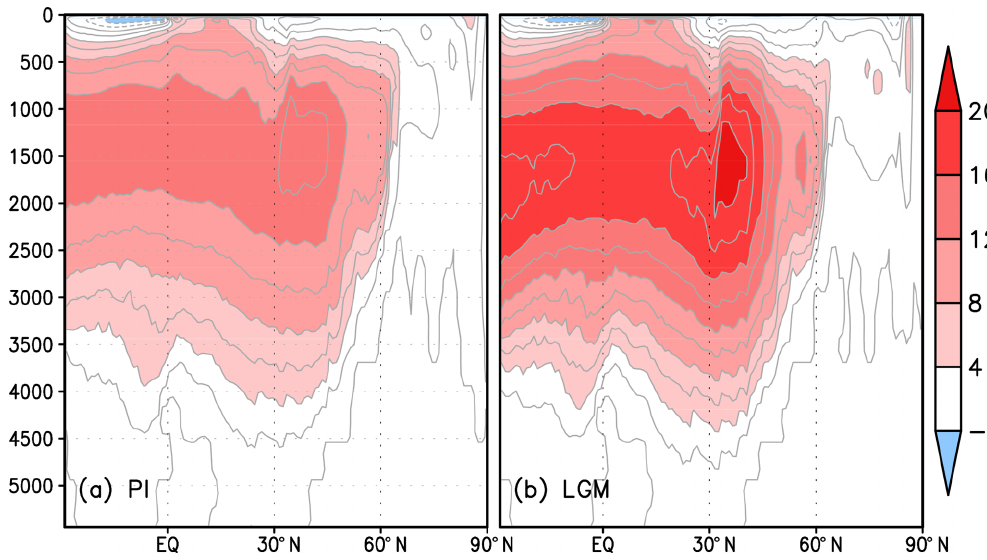
Figure 7. Meridional overturning streamfunction for the Atlantic Basin (unit: Sv) for (a) PI and (b)